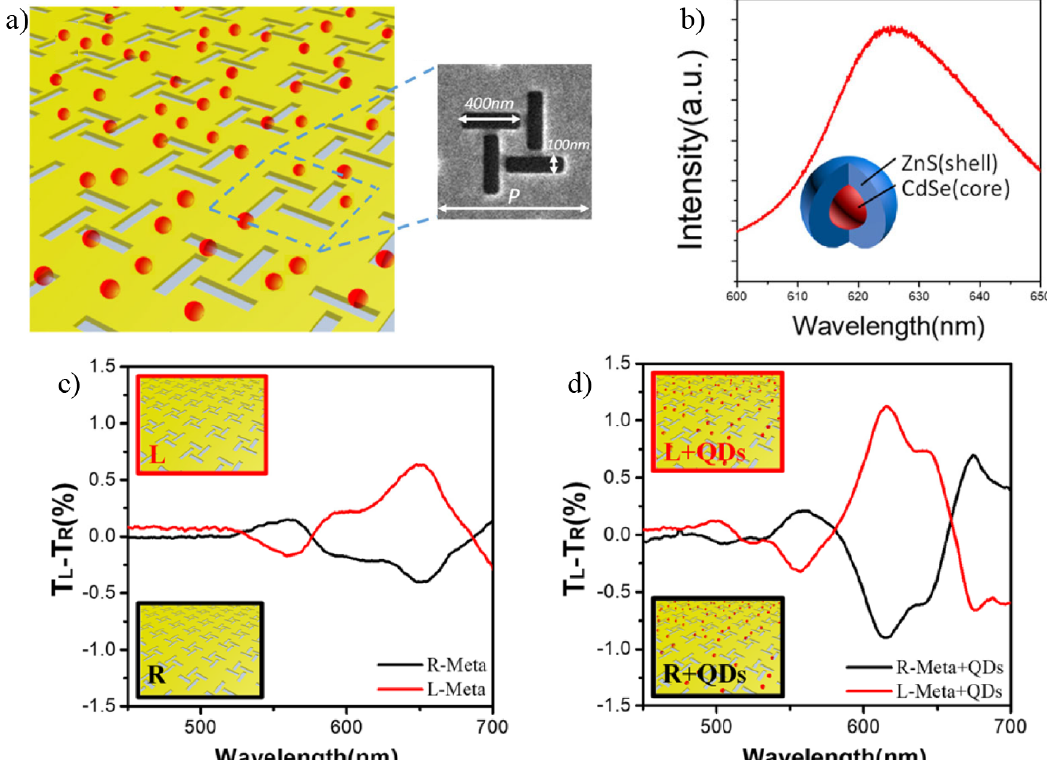
Figure 10. ( a ) Illustrative representation of a hybrid CQDs-plasmonic-metasurface. The inset shows a SEM image of the plasmonic unit cell. ( b ) Photoluminescence spectrum of core-shell CQDs, schematically shown in the inset. For comparative purposes, ( c ) and ( d ) show the results for CDT spectra without and with CQDs. Reproduced with permission from ref. [94]. Copyright 2019